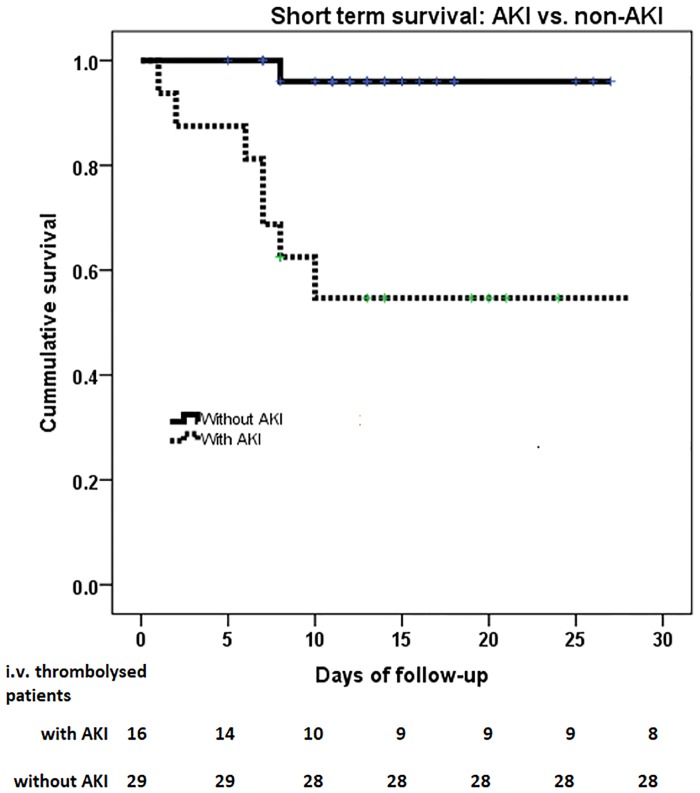
In-hospital survival in iv. rt-PA treated patients with AKI and those without AKI.